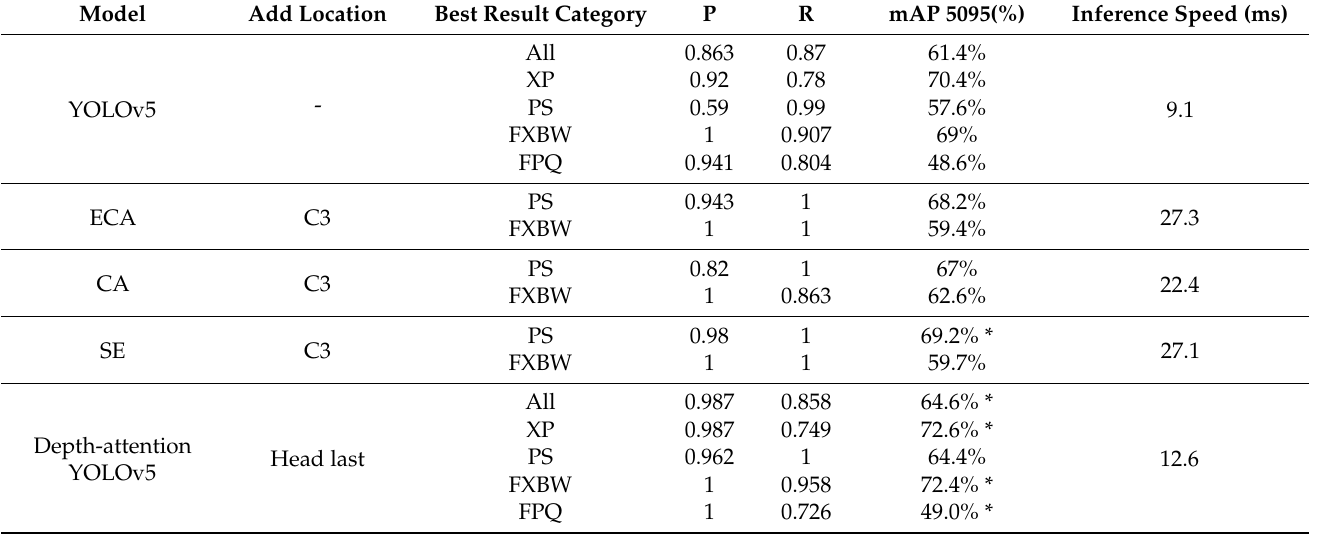
Figure 24. Variation trend of training metrics in the experiment. ( a ) mAP5095; ( b ) recall. Table 5. Performance comparison with the YOLOv5 model and the depth-attention YOLOv5 model.